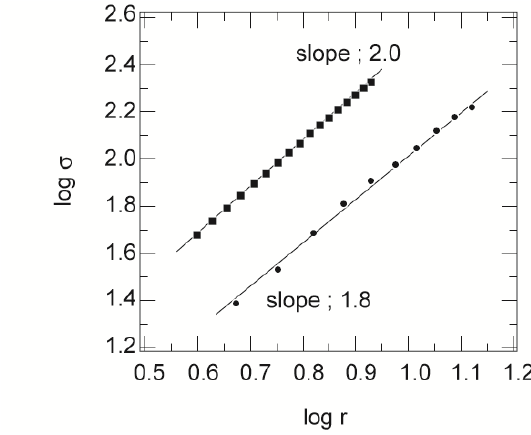
Figure 6. The double logarithmic plot of r (in units of micrometers) and σ (in units of squared micrometers). Only typical results are shown here. The squares are the mole fraction of the cross-linker of 0.2, and the circles are the mole fraction of the cross-linker of 0.5, at a total concentration of 700 mM. The straight lines are the results of the least squares fit.